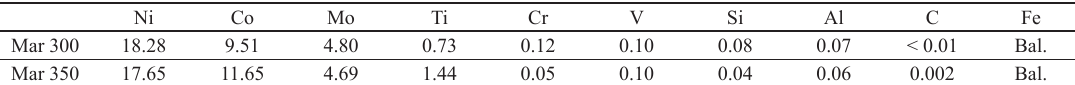
Table 1. Chemical composition of both maraging alloys (% wt.).